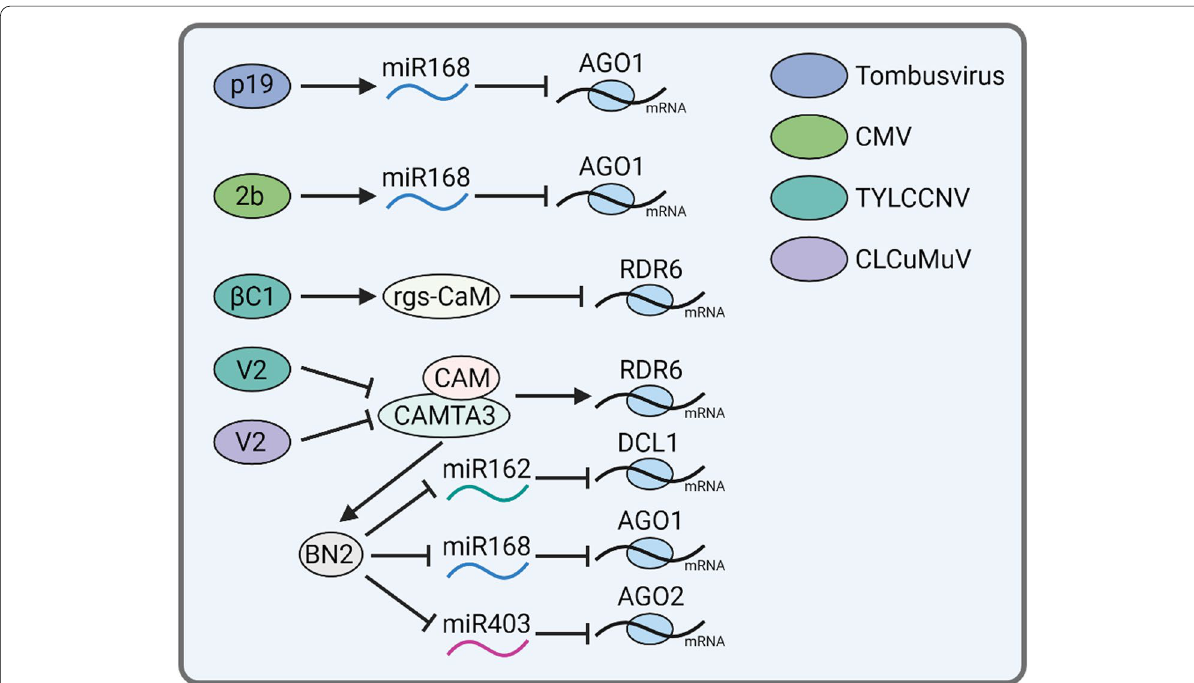
Fig. 4 Viral protein regulates host RNAi-related gene expression during plant–virus interaction. Tombusvirus p19 mediates the induction of the miR168 expression to down-regulate endogenous AGO1 mRNA level. CMV 2b protein inhibits miRNA pathways by blocking AGO1 cleavage activity to upregulate miR168. TYLCCNV-encoded VSR βC1 represses RDR6 expression through transcript induction of an endogenous suppressors of RNAi, Nbrgs ‐ CaM protein to fight against the host RNA ‐ silencing ‐ mediated defense. CLCuMuV and TYLCCNV V2 proteins can disrupt the CaM-CAMTA3 interaction to impair CAMTA3-mediated transcriptional activation of both RDR6 and BN2 , result in suppression of antiviral RNAi. Arrow and T-sign indicate positive or negative impact,